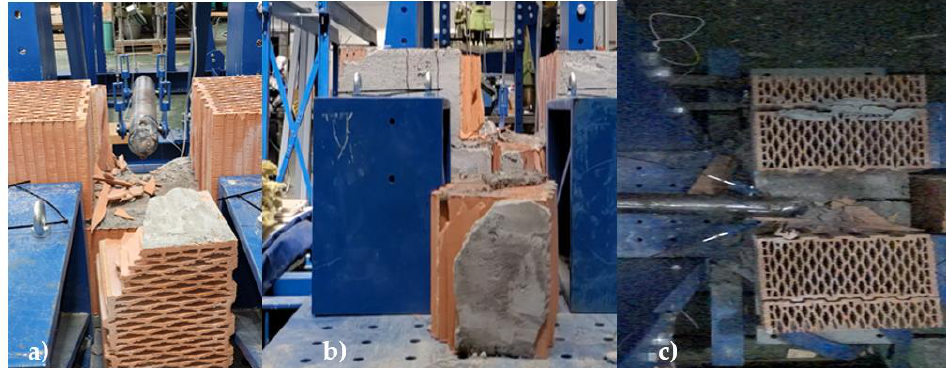
Figure 7. Failure of masonry mortar — ( a ) gradual increase method, ( b ) maximum height method, ( c ) constant height method.